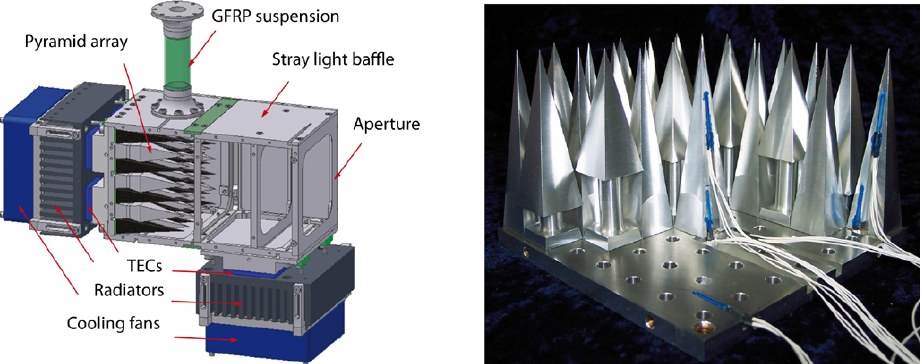
Fig. 3. Left: schematic diagram of a GLORIA blackbody; right: partly assembled prototype version of the pyramid array which forms the radiating optical surface of a GLORIA blackbody. Three different types of uncoated pyramids are noticeable. The position of platinum resistance thermometers in the pyramids and the base plate are marked in blue.